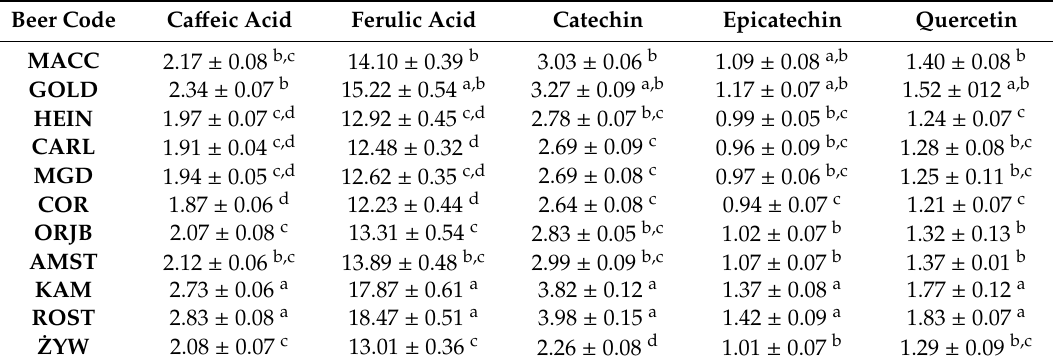
Table 2. Individual phenolic compounds of beer samples (mg /